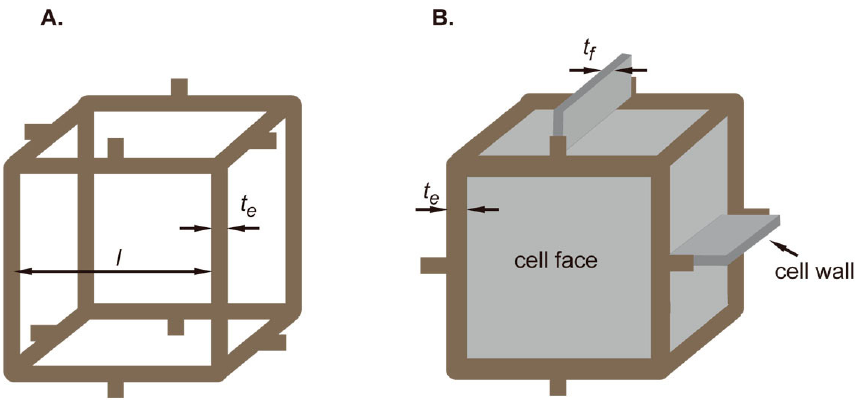
Figure 9. ( A ) A representative basic cubic unit cell used for predicting the modulus of network scaffold; ( B ) A corresponding closed-foam unit cell showing the cell edges and cell face thickness used for predicting the modulus of the composite scaffold.